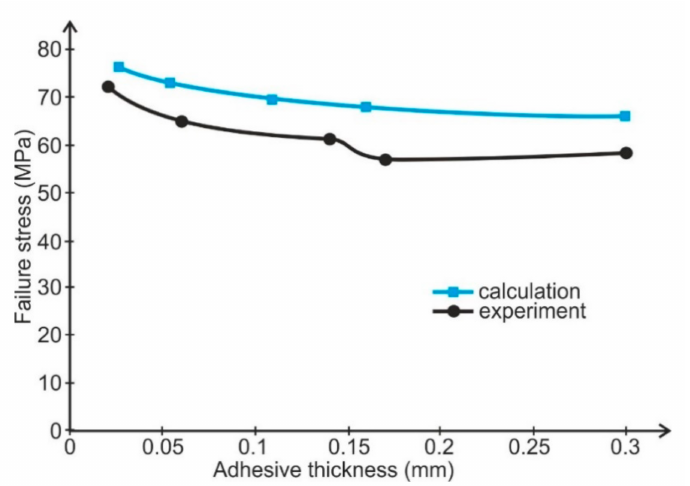
Figure 11. Comparison of AW 136H adhesive failure stresses determined experimentally using butt specimens with FEM calculated failure stresses for lap